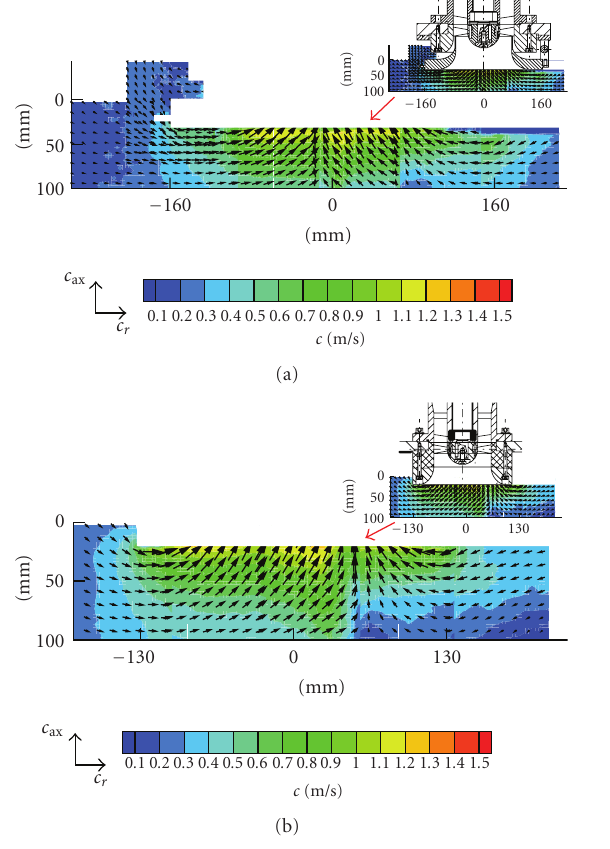
Figure 9: Inlet flow of the double-inlet-nozzle (a) and of the original casing (b) near design conditions, Q/Q opt = 1 . 06, c = ( c 2 + c 2 ) 1 / 2 . ax r